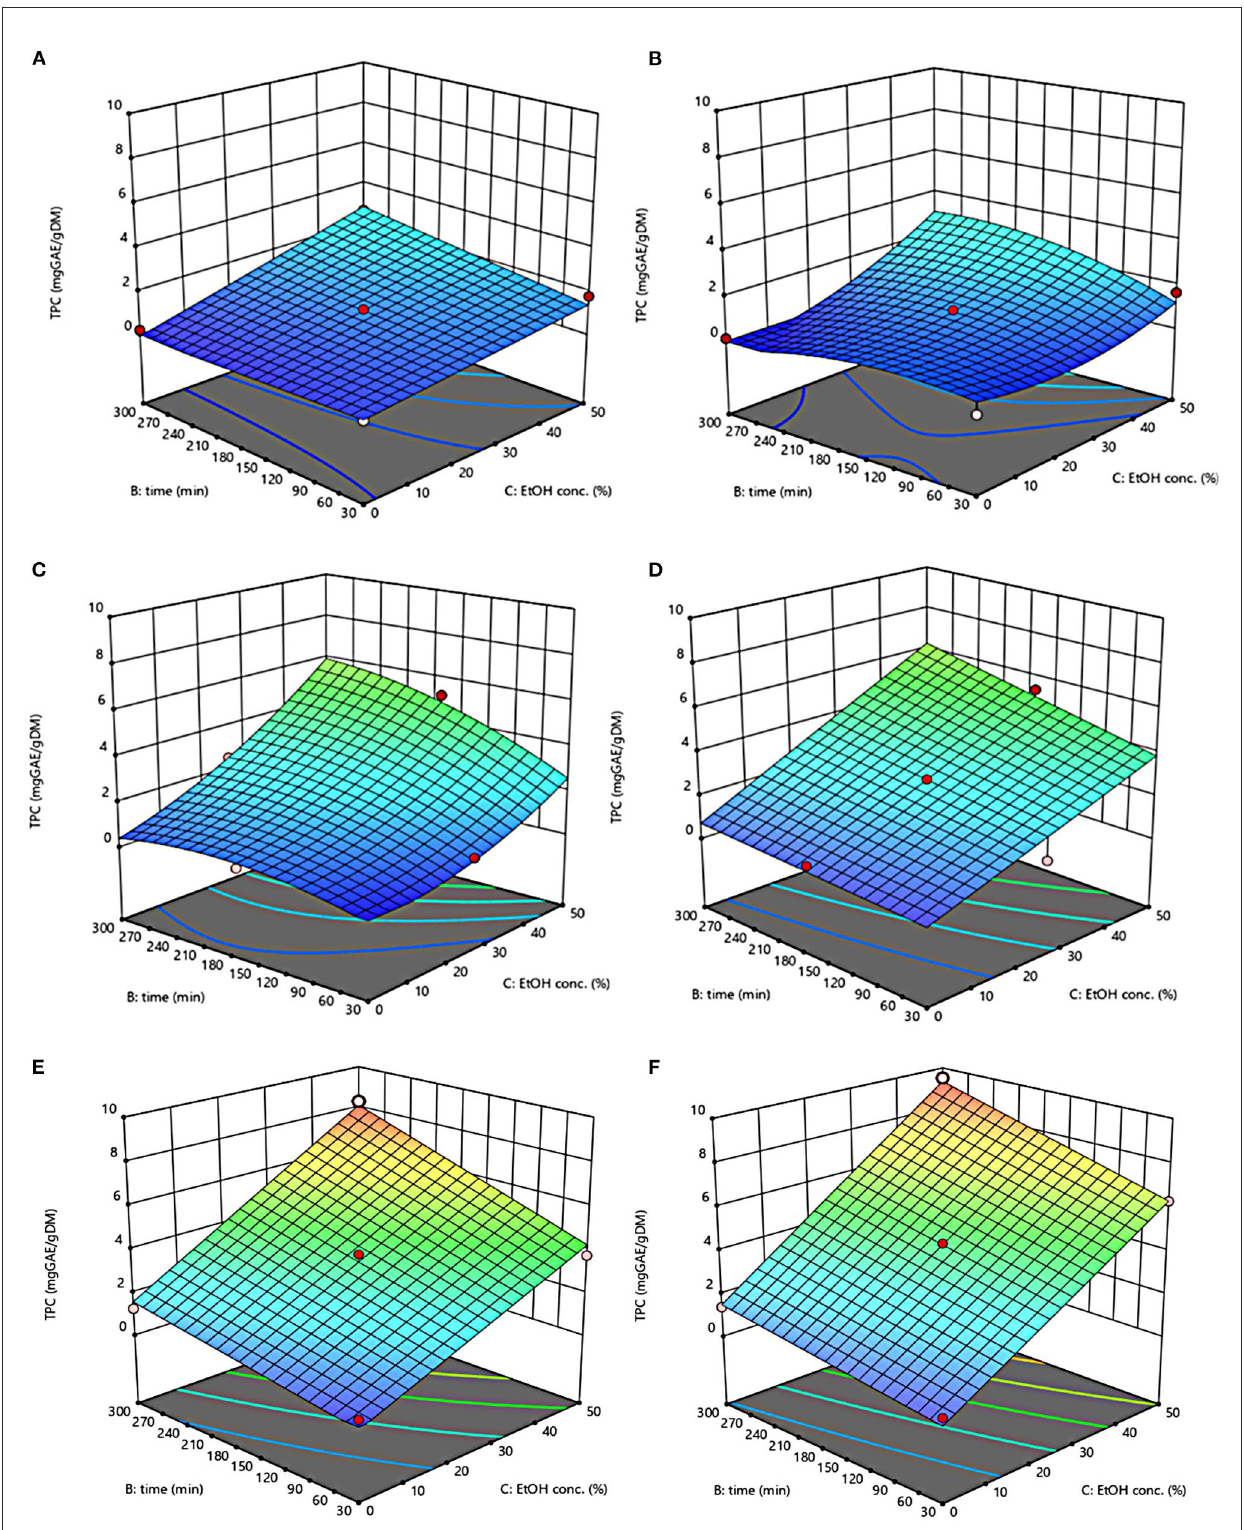
FIGURE2 Response surfaces of Total Phenolic Content (TPC) of extracts from untreated (Control) (A, C, E) and PEF-treated (E = 4.6 kV/cm; WT = 20kJ/kg) (B, D, F) grape pomace as a function of extraction time and ethanol concentration-Extraction temperature set at 20 ◦ C (A, B) , 35 ◦ C (C, D) , 50 ◦ C (E, F) .